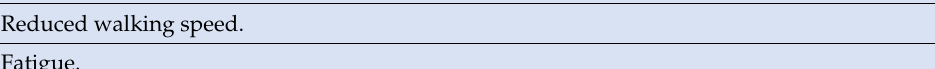
Table 1. Fried’s Frailty Criteria.